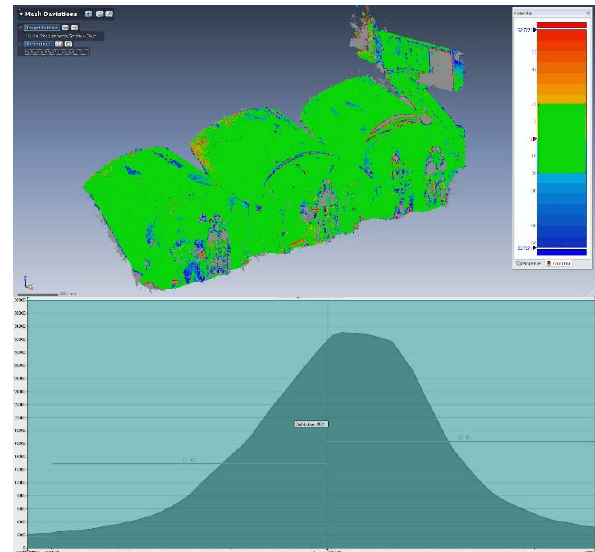
Figure 13. Graphic and numerical deviation between point clouds.